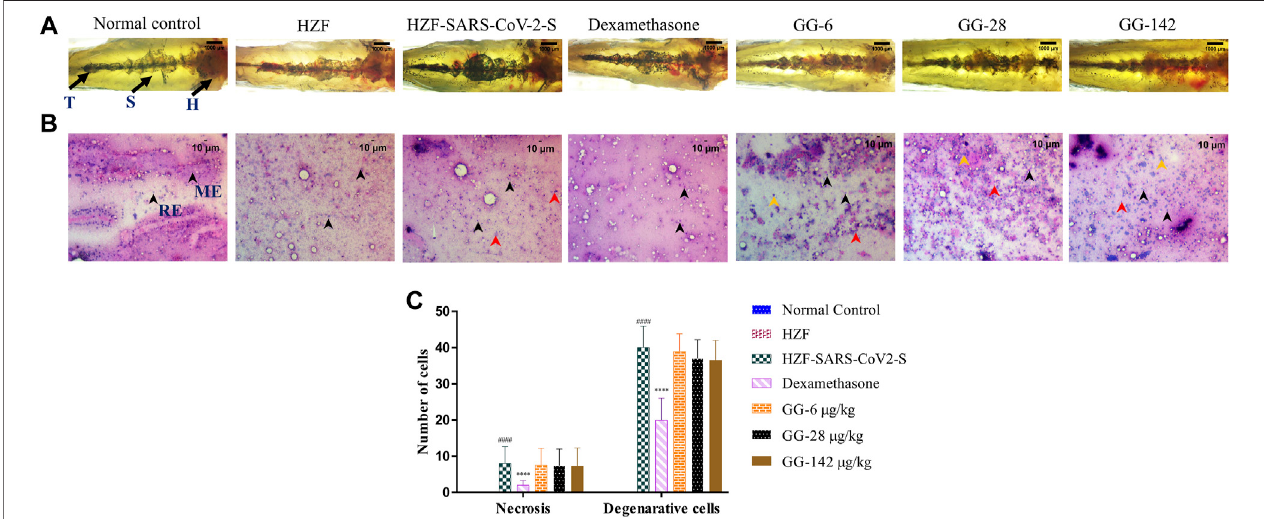
FIGURE5| Changestothestructure,cytology,and quantitationofnecroticand degenerativecells at 4-daystime point. (A) Structural examination ofthekidneyat 1X using transmitted light. Melanocytes appear as dark pigmented granules. The three regions of the kidney Head (H), Trunk or Saddle (S), and Tail (T) extend from the anterior to the posterior of the body. (B) Cytological examination of hematoxylin-eosin stained smears of kidney tissue imaged at × 20 objective magni fi cation. Black arrowheads depict nuclei of normal cells, yellow show degenerative cells while red show necrotic cells. (C) Quantitation of kidney damage as assessed by the presence of degenerative and necrotic cells in cytological smears. Data points represent mean ± S.D. analyzed by Two-Way ANOVA followed by Tukey ’ s multiple comparisons test. (****) p < 0.0001 compared to disease control, n (cid:2) 24.